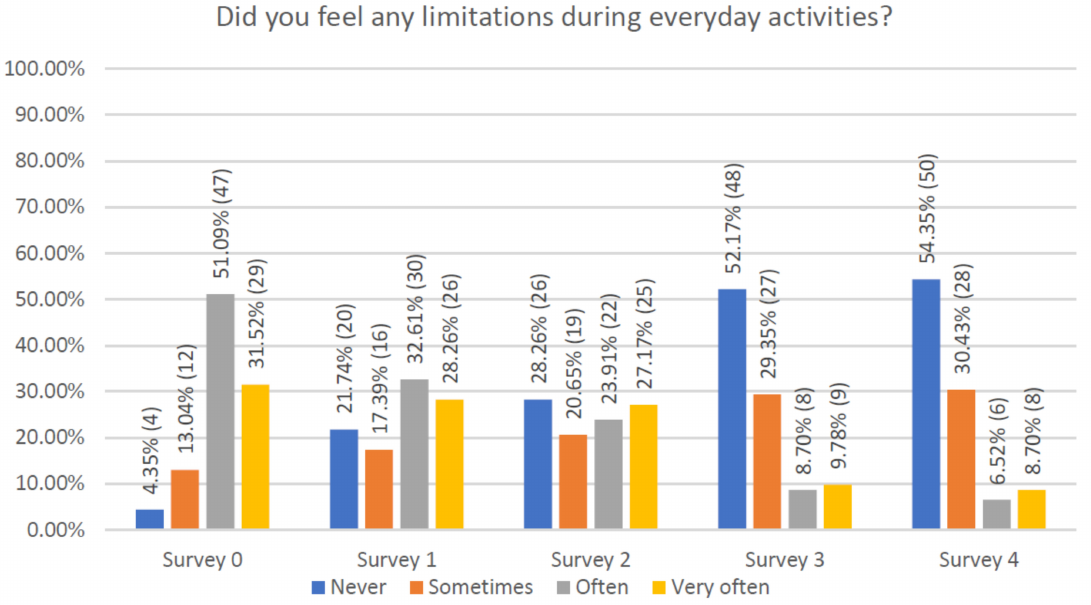
Figure 2. Assessment of limitations during performance of everyday